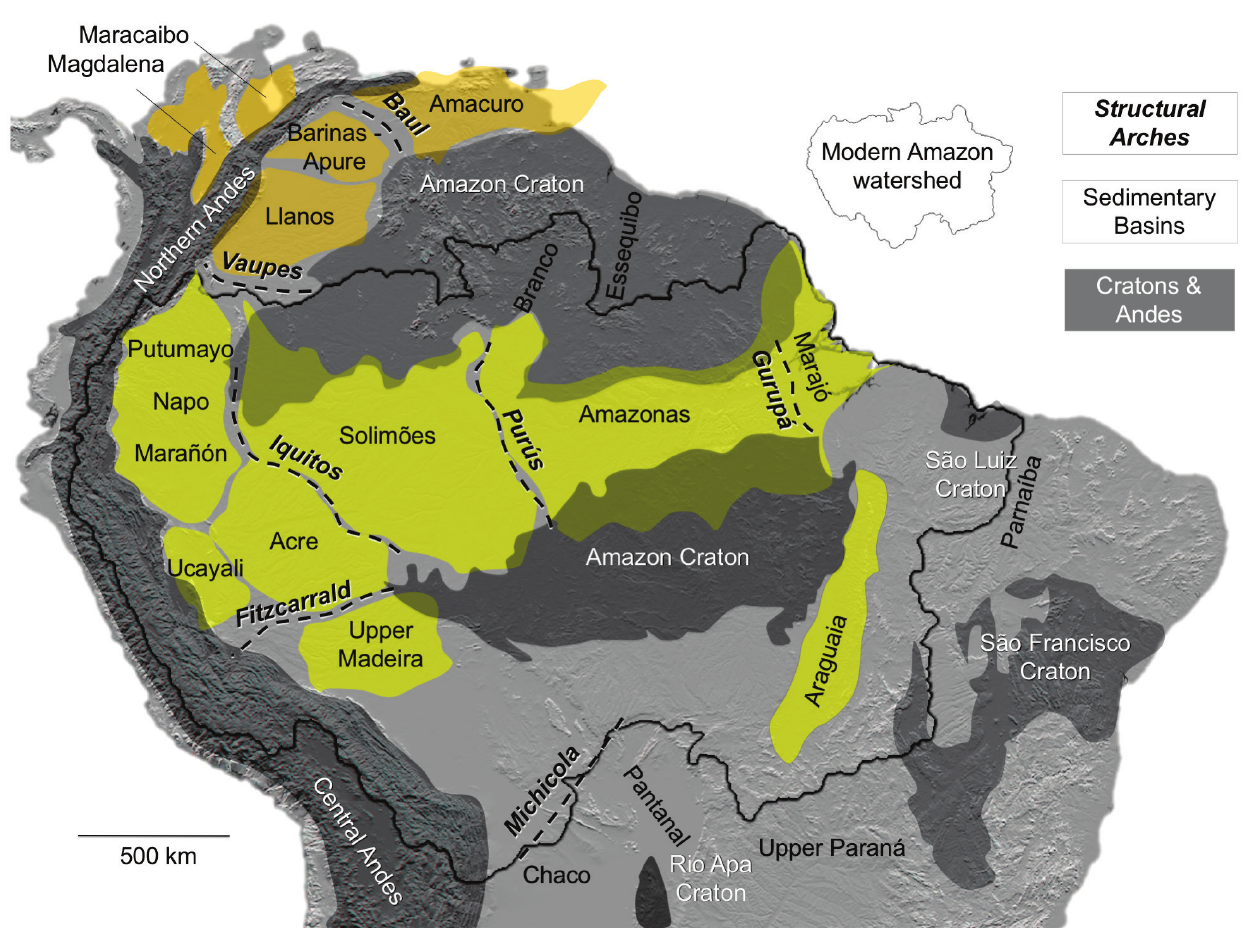
Fig. 3. Principle landforms controlling basin connectivity in northern South America. Structural arches (dashed lines) of diverse geological origins partially bounding sedimentary basins. Sedimentary basins in orange draining to the Caribbean; in yellow to the Atlantic. Structural arches and sedimentary basins from Costa Menegazzo et al . (2016) and Jaramillo et al . (2017). Note the Guiana Shield is composed mostly of the northern Amazon Craton, the Brazilian Shield by the southern Amazon craton, and the Atlantic Shield by the São Luís, São Francisco, Luís Alves and Río de la Plata cratons, all overlaid in parts with Paleozoic sedimentary